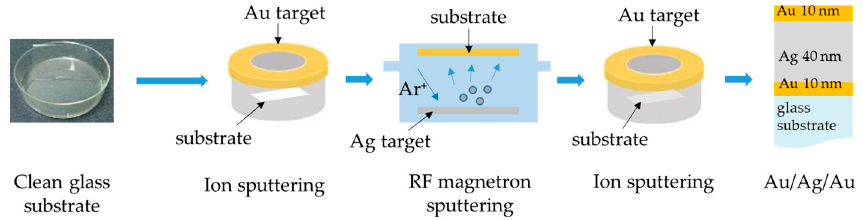
Figure 2. Deposition of multi-metallic nanostructures.